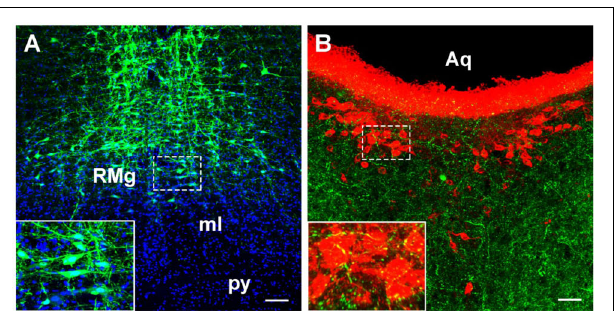
FIGURE 11 | The verification of the RMg projection to the CSF-contacting nucleus by anterograde tracing. (A) The injection site of the anterograde tracer rAAV2/9-hSyn-EGFP into the RMg. (B) The axon terminals of the RMg (green) make close appositions with the neurons in the CSF-contacting nucleus (red). RMg, raphe magnus nucleus; py, pyramidal tract; ml, medial lemniscus; Aq, aqueduct. Scale bar = 100 µ m in A ; Scale bar = 50 µ m in B . from these regions to the CSF-contacting nucleus is shown in Figure 13